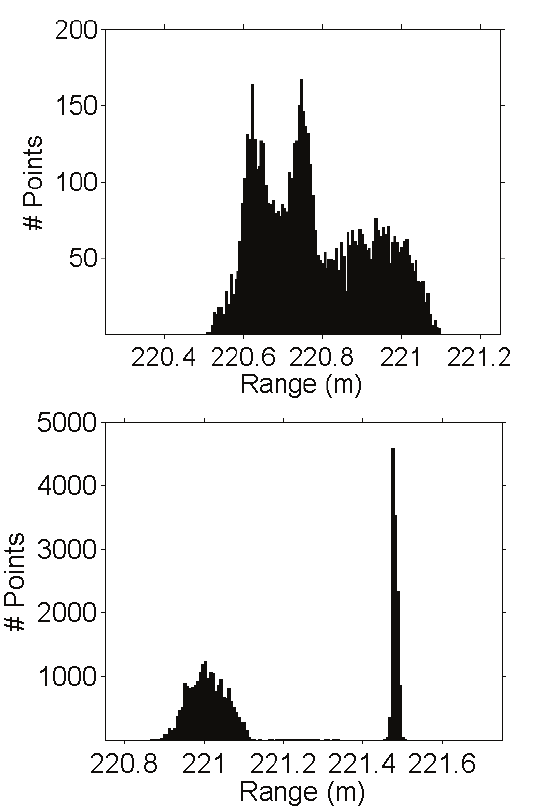
Figure 3: Range return histograms of Target 1 area for (Top) VZ- 400 and (Bottom) HRS-3D